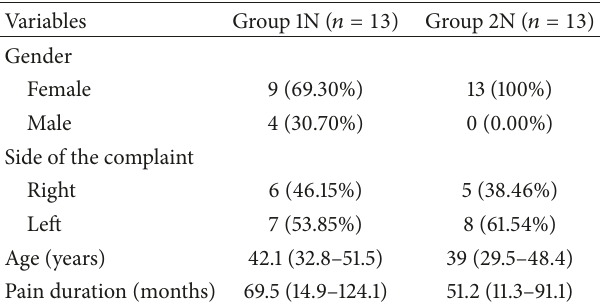
Table 1: Frequency distribution, means, and confidence intervals of the descriptive variables of the sample.